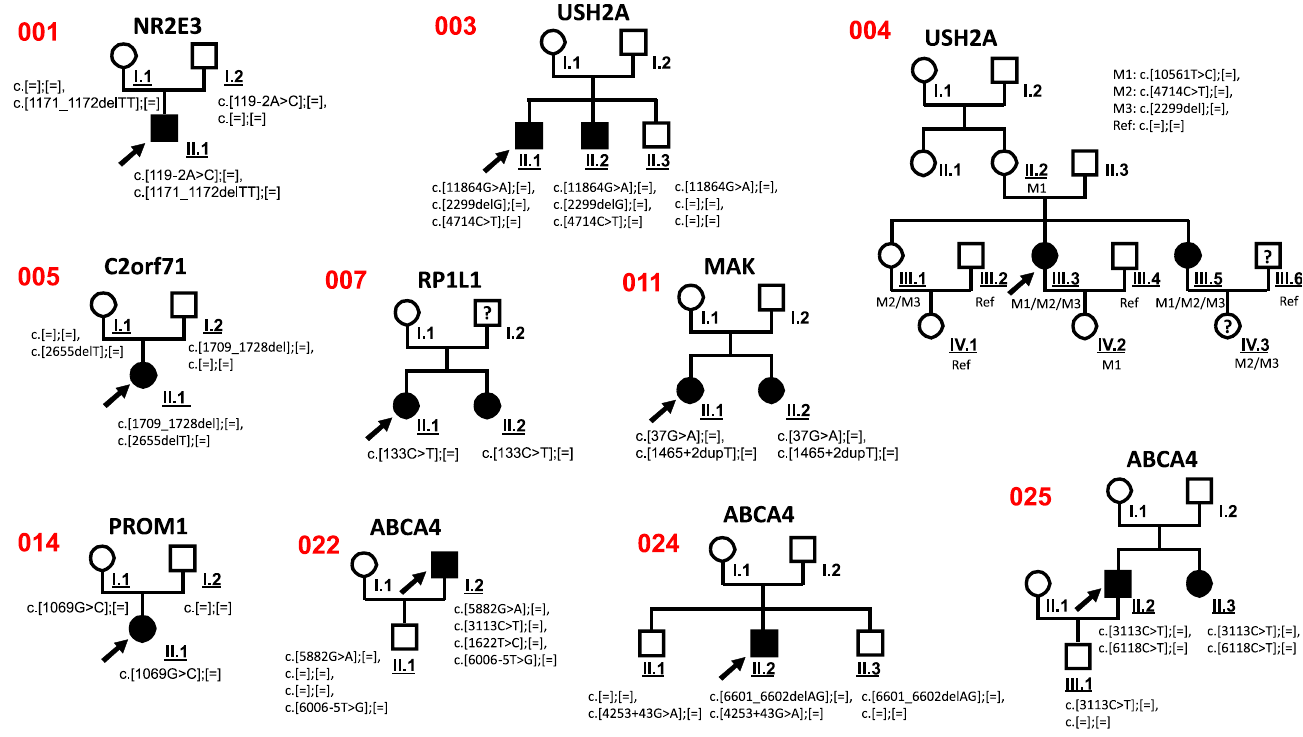
Figure 3. Pedigrees of all RD-affected patients for whom co-segregation analyses were performed. Black arrowheads indicate the affected index patients in each family. Filled symbols represent affected family members. Co-segregation analyses were performed in the underlined family members. The numbers on the left side of the pedigrees refer to Tables 1 and S1. Question mark: phenotype information not available. M: mutation. Ref: reference sequence.